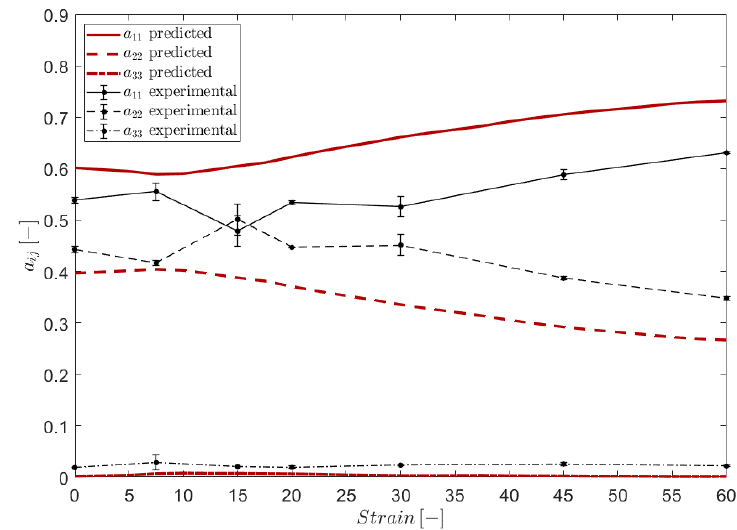
Figure 9. Experimental (black) and predicted (red) fiber orientation evolution of injection molded samples.